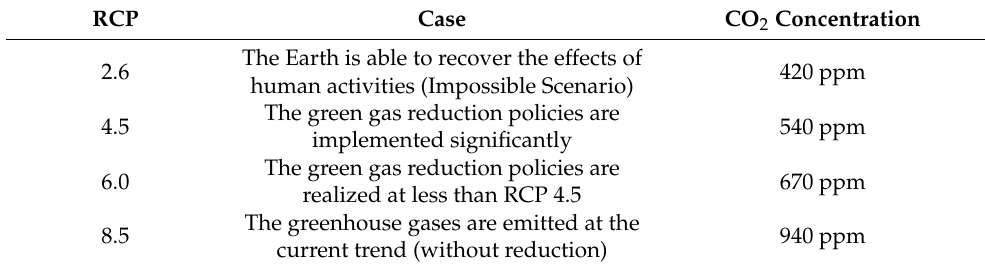
Table 1. Brief explanation of the RCP scenarios (2.6,4.5,6.0, and